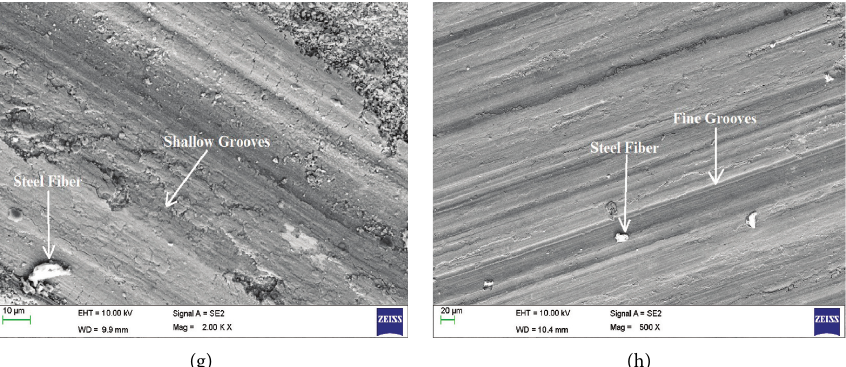
Figure 13: (a–d) FESEM micrographs of damaged surfaces of LM6 Al alloy hybrid mixtures under a load of 10N. (e–h) FESEM micrographs of damaged surfaces of LM6 Al alloy hybrid composites under various load conditions (10N, 20N, 30N, and